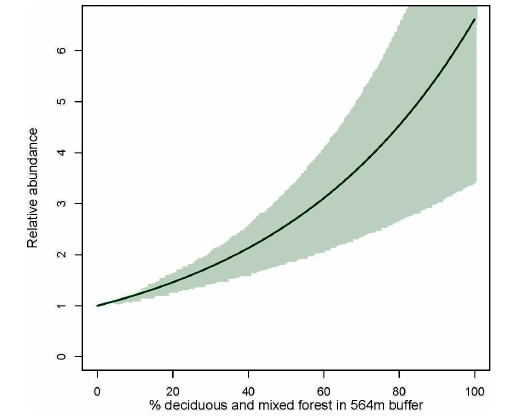
Fig. 5 . Predicted relationship of Canada Warbler relative abundance as a function of percent deciduous forest at the stand (1 km²) scale. Shaded area indicates 90% prediction interval around the mean predicted relationship. Relative abundance is interpreted as a multiplier for local density; i.e., higher amounts of deciduous forest around a point lead to > 1 times the local density compared with the 0% deciduous forest stand-level